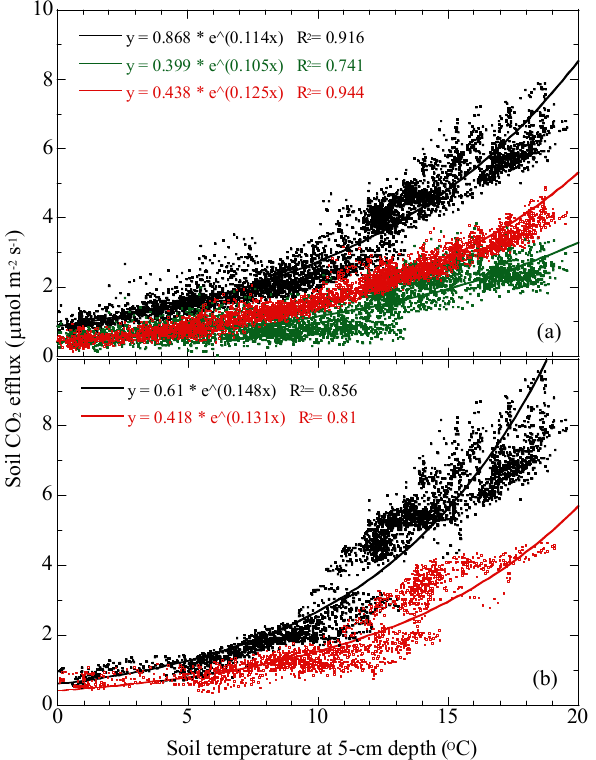
Fig. 4. Fig. 4. Relationships between soil temperature at a depth of 0.05m and (a) total soil CO 2 efflux (black symbols and line), heterotrophic (red symbols and line) and root (green symbols and line) respira- tions measured by the chamber method, and (b) total soil CO 2 ef- flux (black symbols and line) and topsoil (O a and A horizons) CO 2 efflux (red symbols and line) measured by the gradient technique, on an hourly basis. The best-fitted exponential curves are shown.